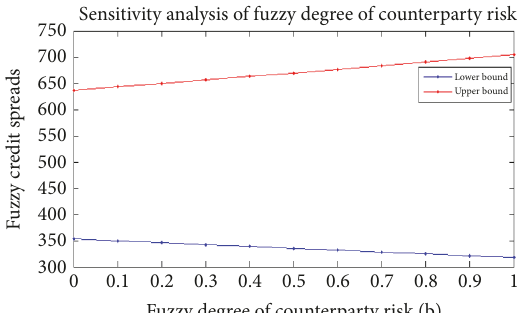
Figure 6: The dynamics between fuzzy credit spreads and external shocks.